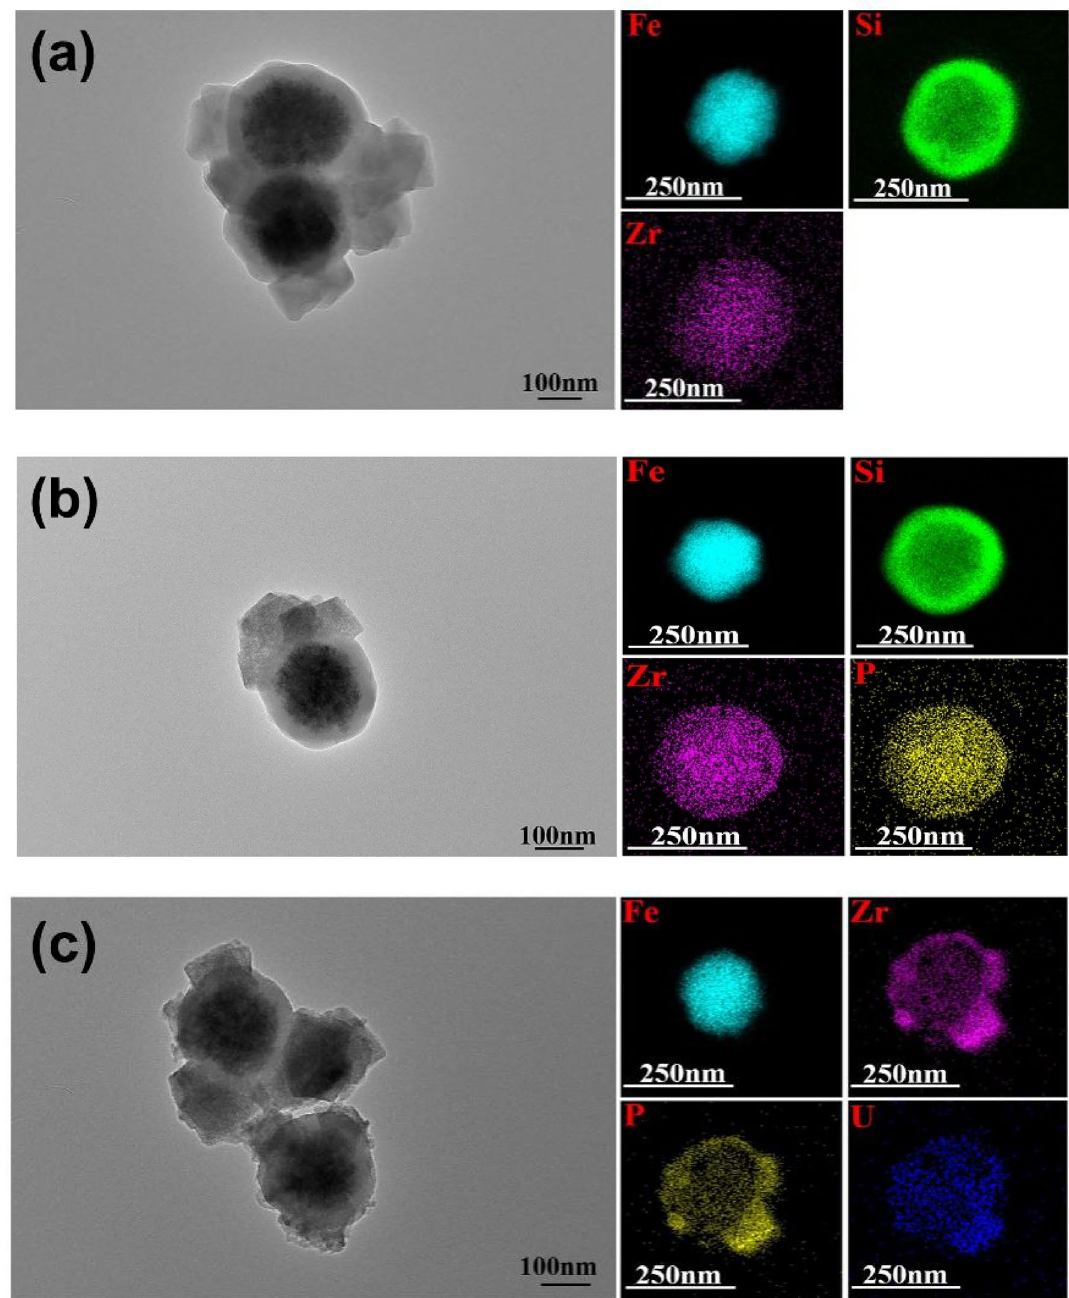
Figure 2. TEM and composition mapping imagesof Fe 3 O 4 @SiO 2 @UiO 2 -66-NH 2 ( a ), Fe 3 O 4 @SiO 2 @UiO 2 -66- TPP ( b ) NPs before and after ( c ) U(VI)